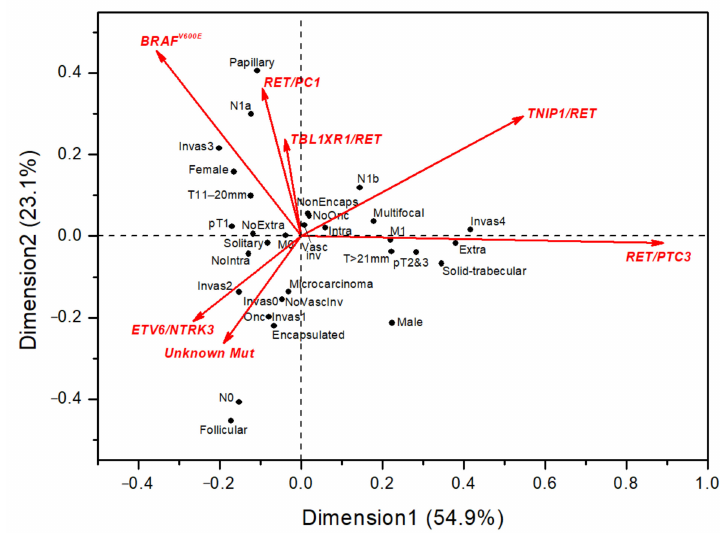
Figure 3. Correspondence analysis of clinicopathological characteristics (black circles) of childhood PTCs with respect to oncogenic drivers (red arrows). The smaller angle between the types of driver mutation indicates their stronger correlation (e.g., between RET/PTC1 and BRAF V600E ), while right or obtuse angles indicate a lack of correlation (note the position of RET/PTC3 against other mutations). The smaller angle between clinicopathological variables indicates similarity in response pattern (e.g., an invasiveness score of 4 would be expected to frequently coexist with tumors displaying extrathy- roidal extension). The distance between the positions of driver oncogenes and clinicopathological variables reflects, to some extent, the association between them (e.g., PTCs with RET/PTC3 are likely to display solid-trabecular, while those with RET/PTC1 display a papillary growth pattern more frequently). Dimension 1 and 2 accounted for 82.1% of variance cumulatively, and the dimensions 3–6 for the remaining 17.9% (not shown).